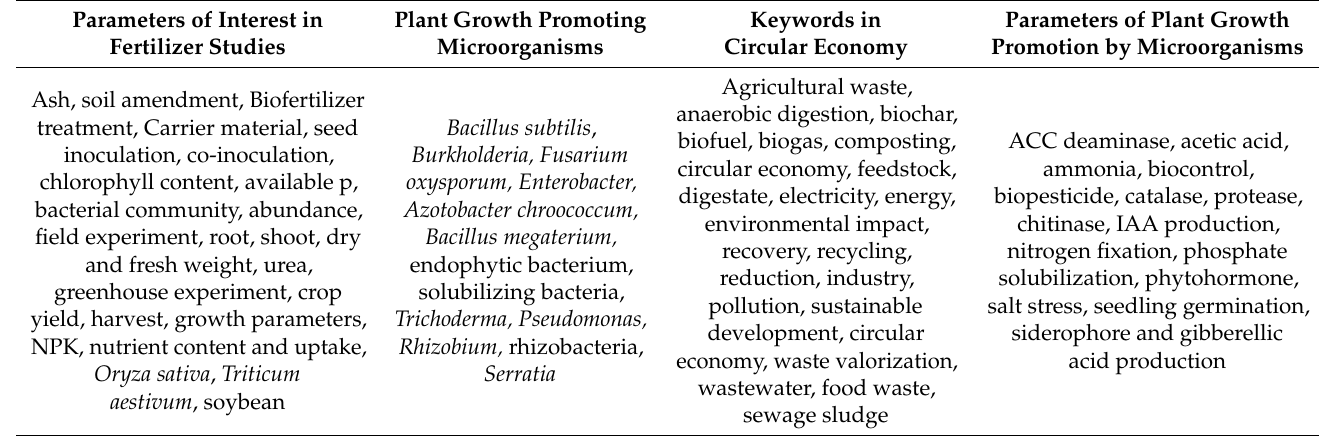
Figure 6. Visualisation of critical terms co-occurrence in textual data used in fertilizer research.